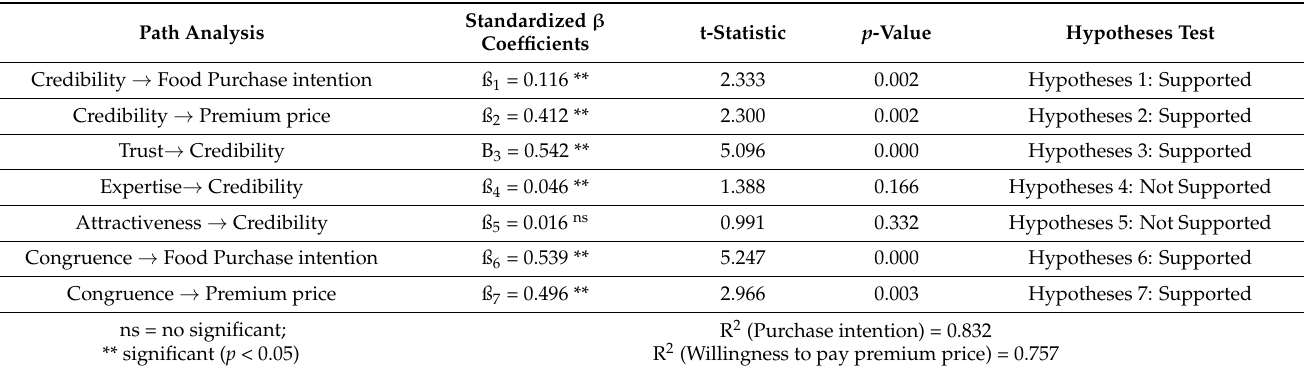
Table 6. Model resolution through PLS consistent